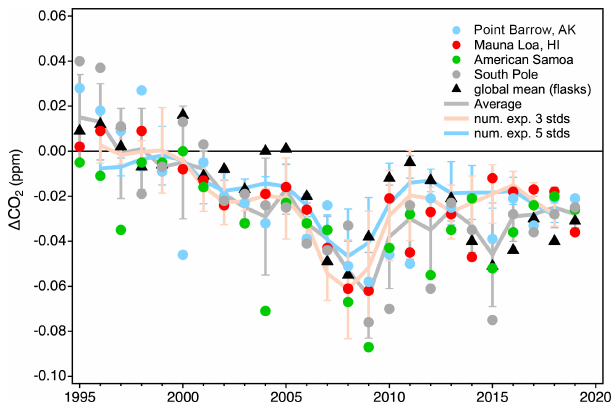
Figure 17. Potential bias that could exist in archive datasets trace- able to NOAA standards prior to the release of X2007, shown as the difference between a hypothetical archived result and that re- sult expressed on scale X2007 (derived from a sample of standards analyzed from 1993 to